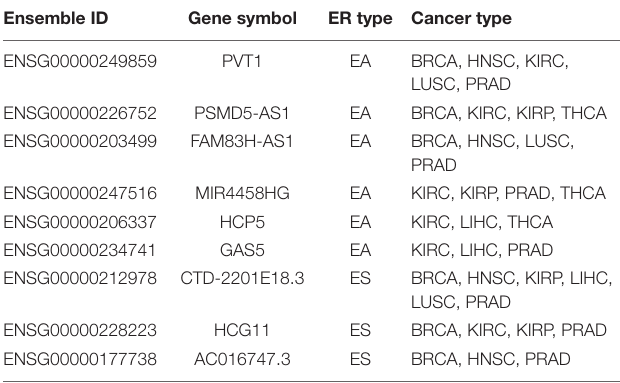
TABLE 2 | Detailed information of nine epigenetically related